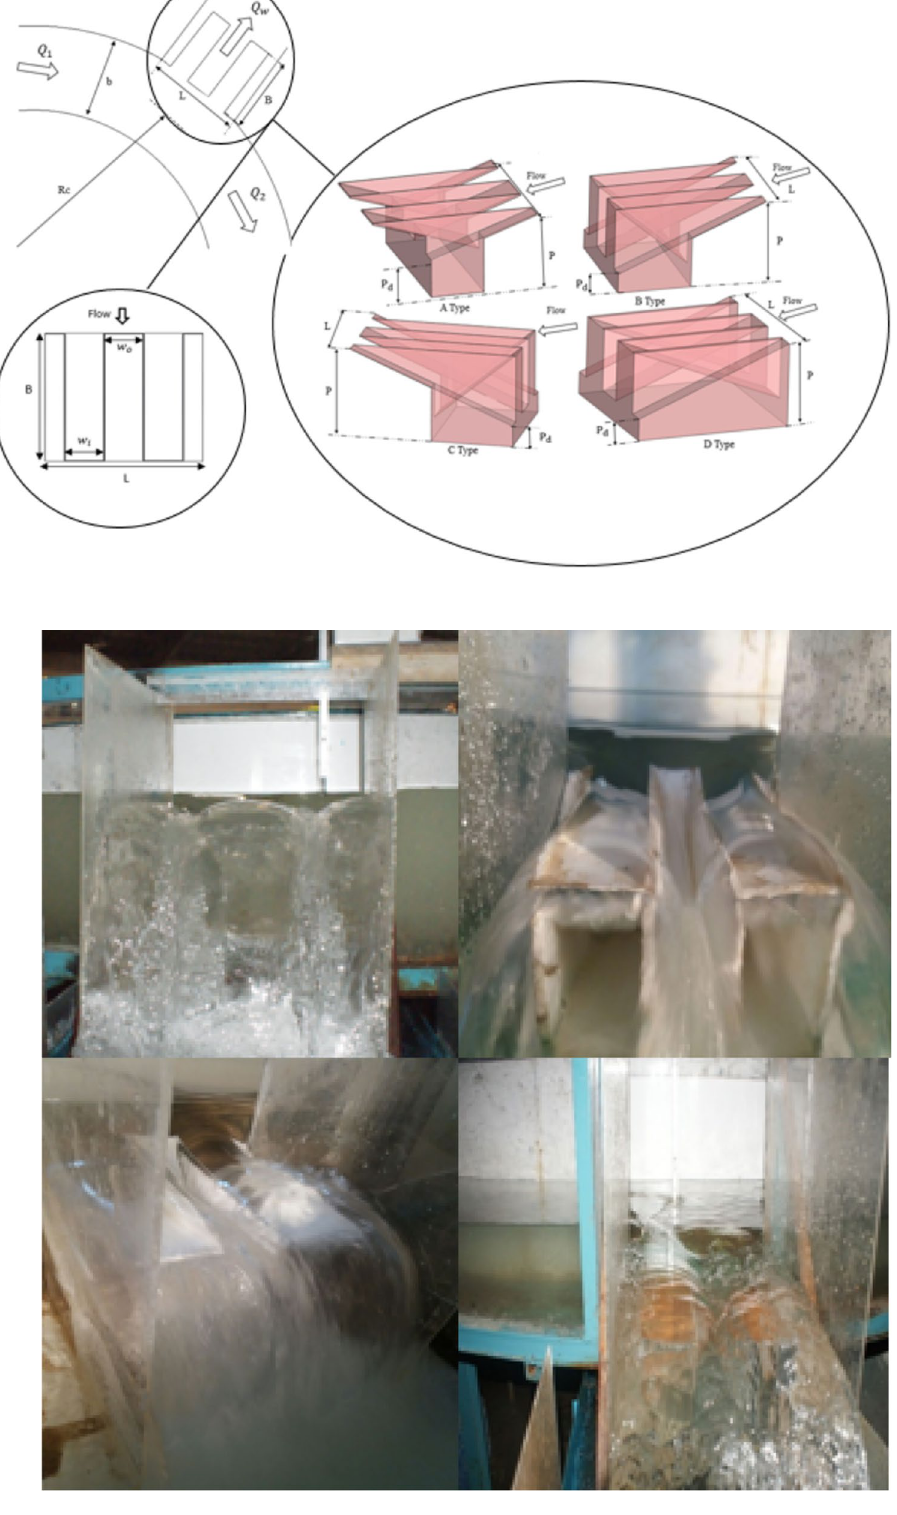
Fig. 4 A schematic view of RPKSW